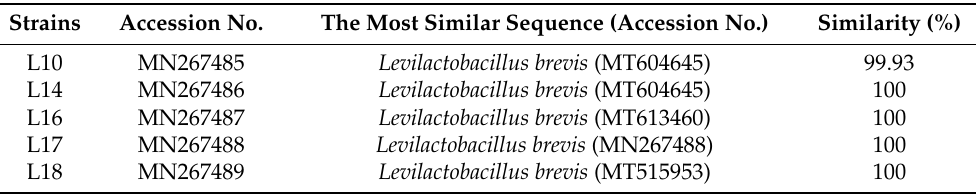
Table 6. Blast results of selected 5 strains by 16S rRNA gene sequence. Strains Accession No. The Most Similar Sequence (Accession